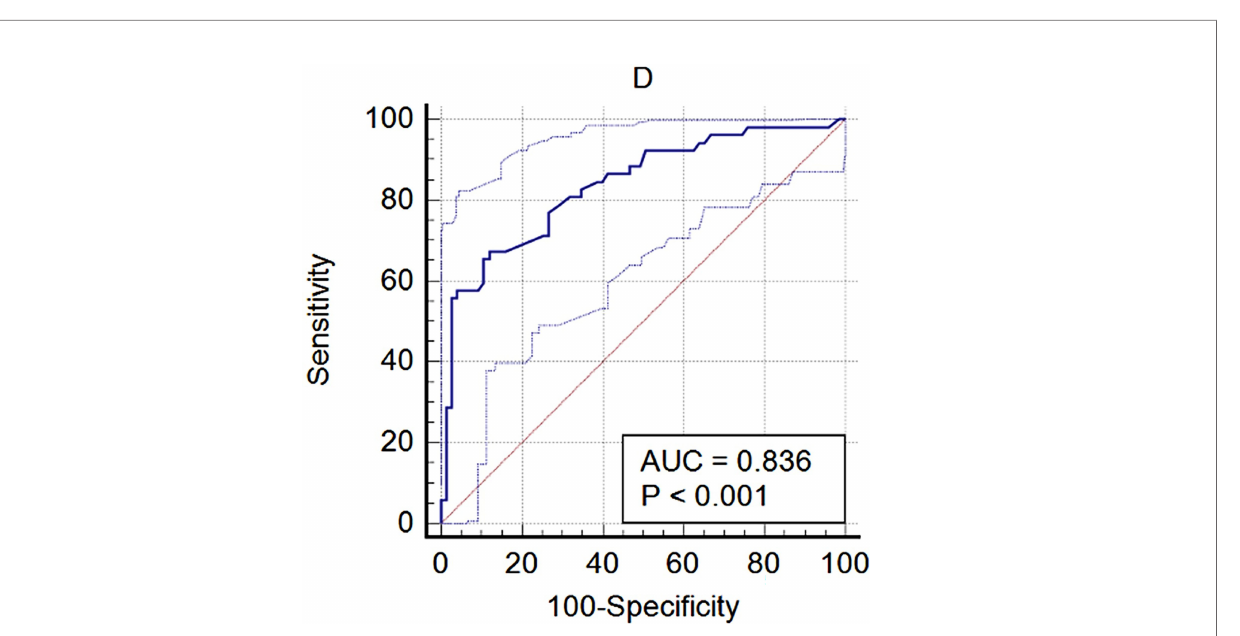
FIGURE 4 | The diagnostic performance of D1 with pituitary